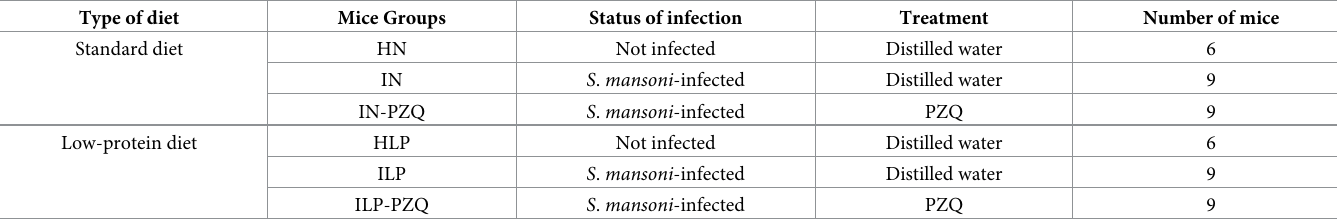
Table 2. Experimental